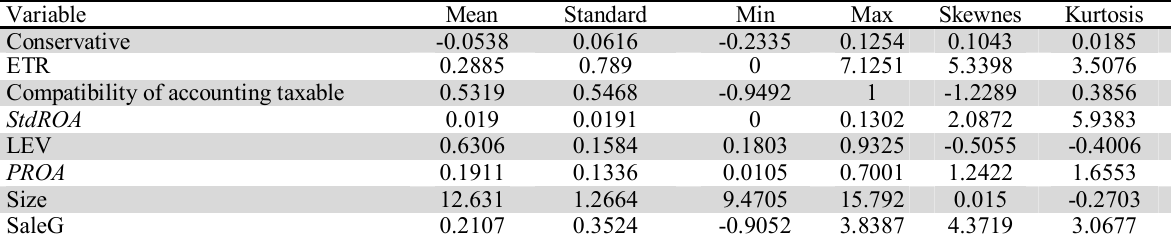
The summary of some basic statistics